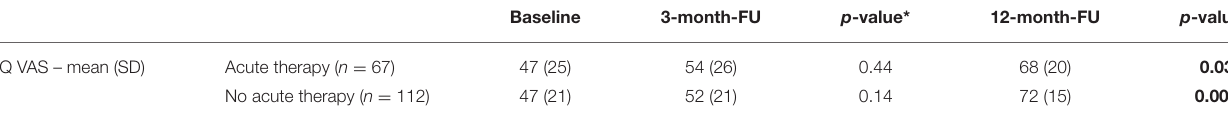
TABLE 4 | Long-term course of patient-reported health (EQ VAS) of severely affected patients (mRS 3-5). Baseline 3-month-FU p -value* 12-month-FU p -value